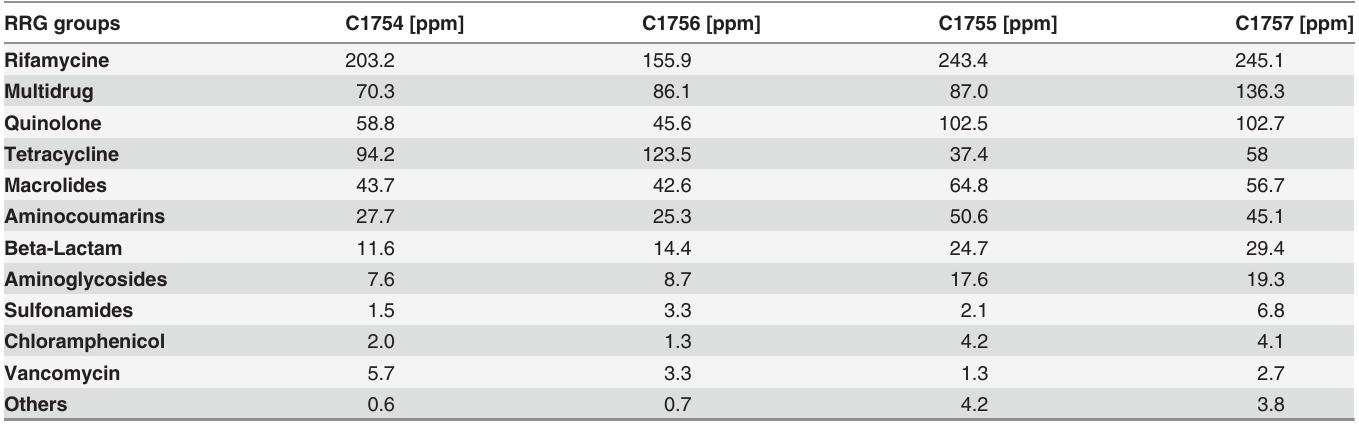
Table 3. Distribution of RRG-groups in the samples.